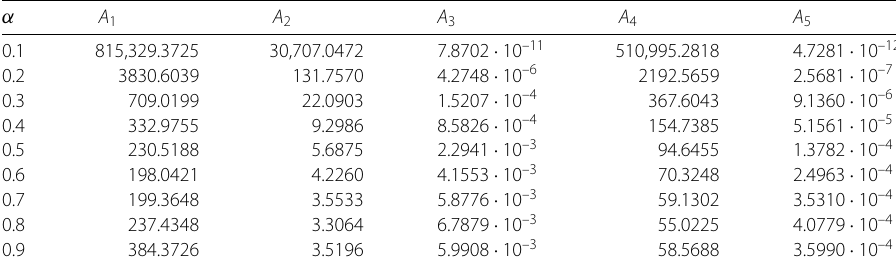
Table 1 Explicit constants for Example